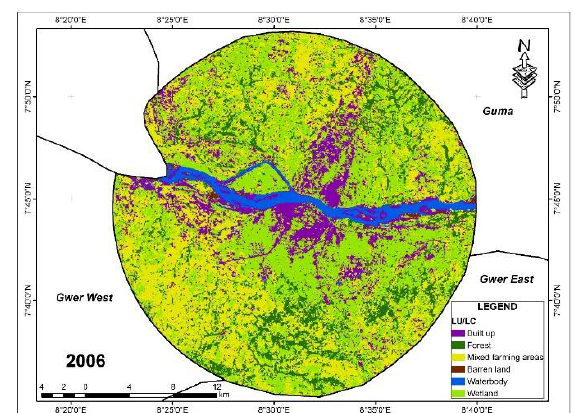
Figure 4. Landuse composition of study area in